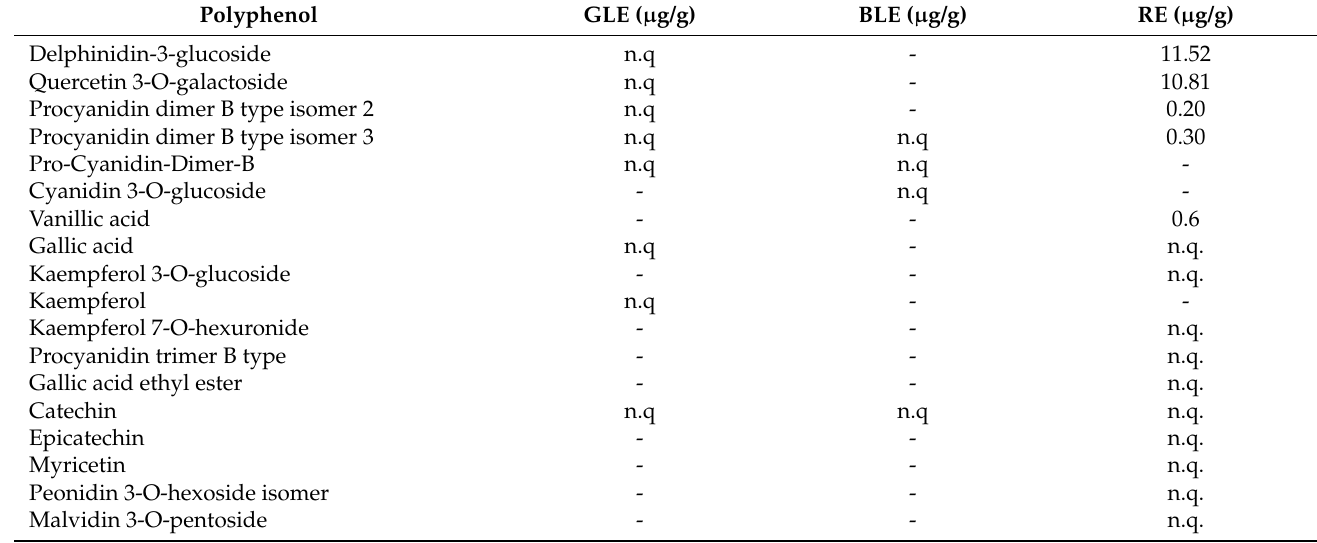
Table 2. Quali-quantitative determination of the phenolic components of GLE, BLE, and RE. n.q.— not